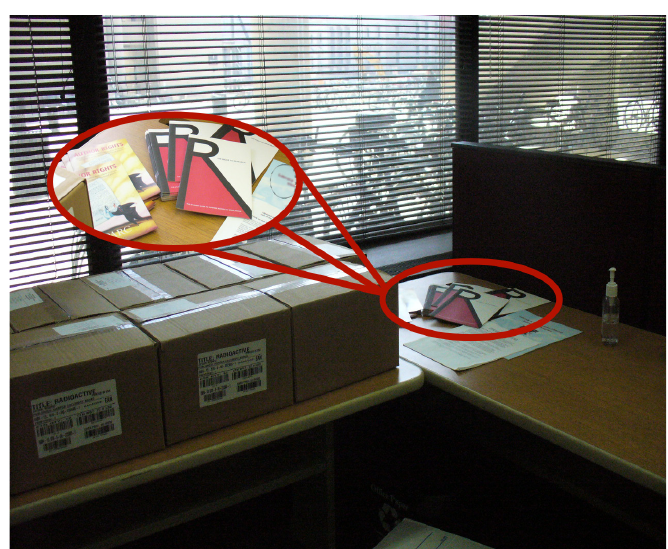
Figure 1. Properly-placed scholarly